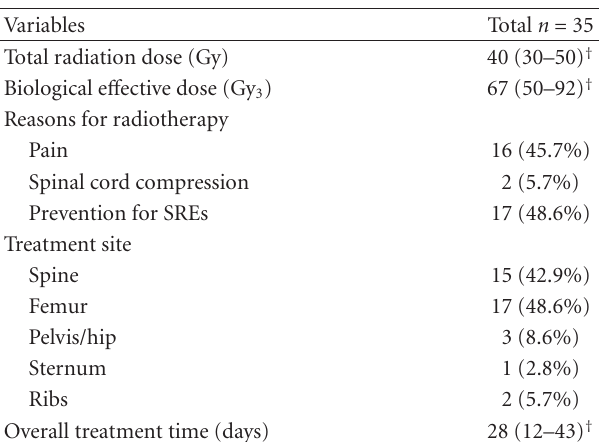
Table 2: Treatment characteristics.